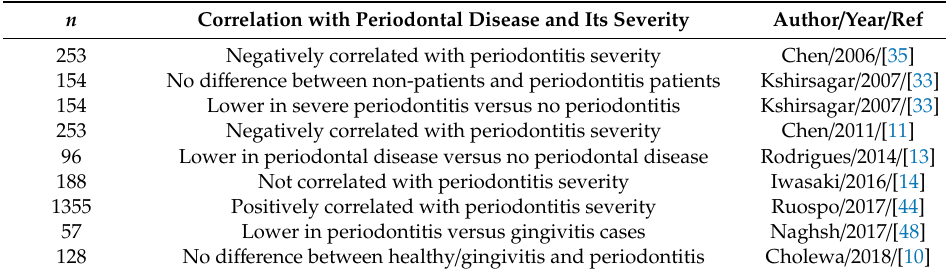
Table 3. Relationships between serum albumin levels and periodontal